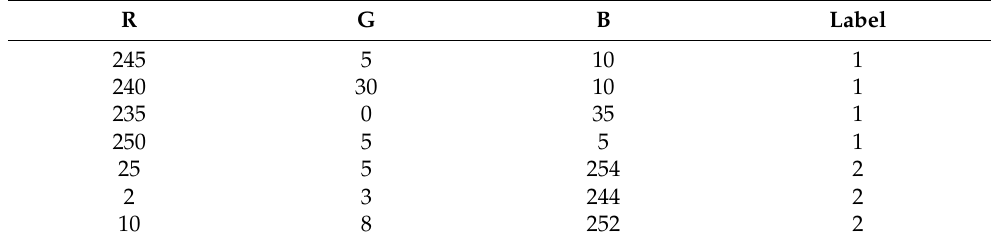
Table 2. A sample of the labelling for the input EBSD image data, which was used as the training dataset. R G B Label 245 5 10